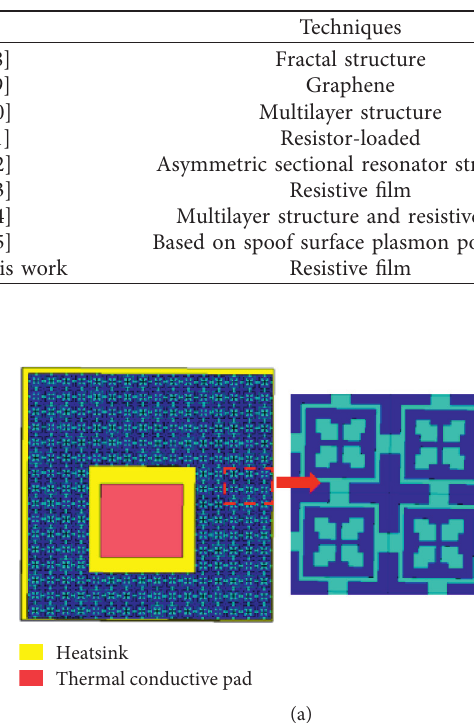
Figure 23: Absorptivity at different polarizations. Table 2: Comparison with other metamaterial absorbers.